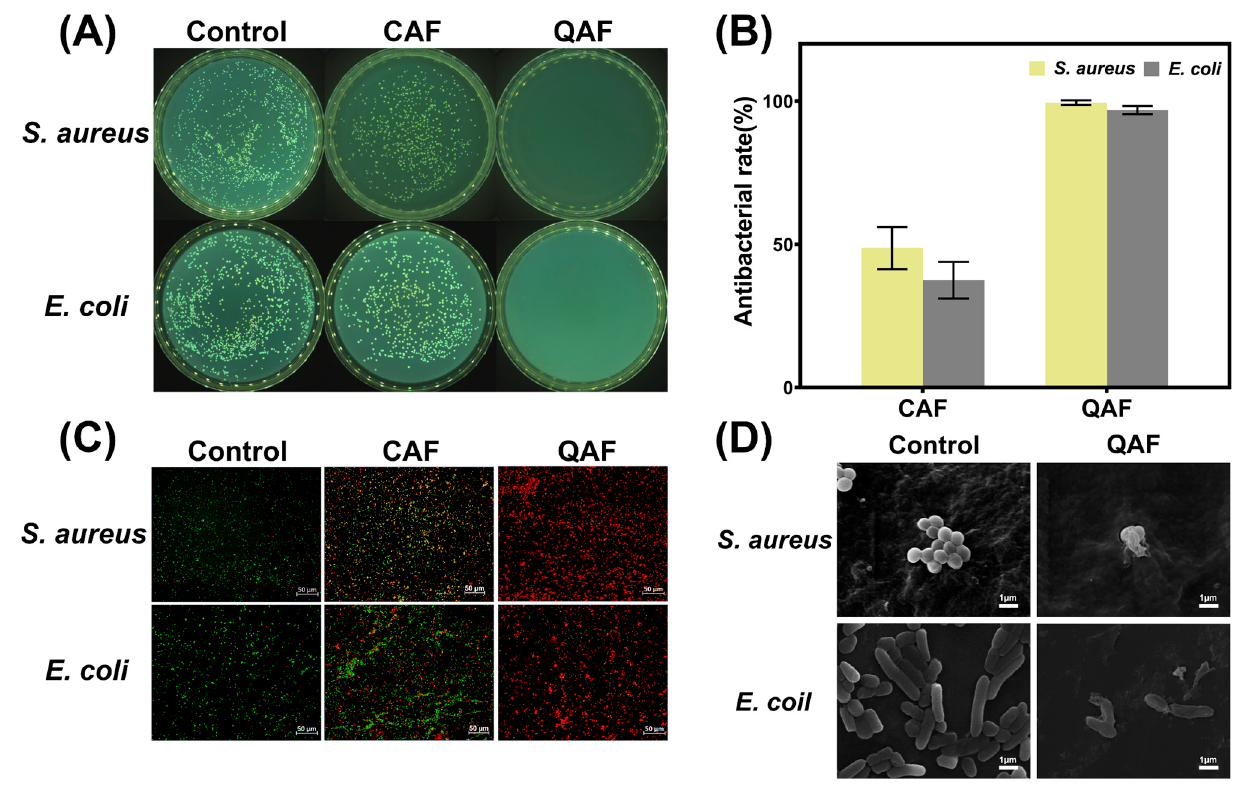
Figure 5. Antibacterial properties of hydrogels. ( A ) The counter board pictures of S. aureus and E. coli growth on QAF and CAF hydrogels; ( B ) Antibacterial rates of QAF and CAF hydrogels ( n = 3); ( C ) FDA/PI fluorescence staining images of S. aureus and E. coli cultured with extracts of QAF and CAF hydrogels for 12 h. ( D ) SEM images of S. aureus and E. coli after contact with QAF hydrogels for 12 h.